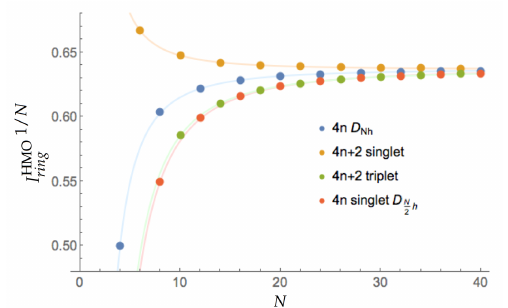
Figure 1. Values of I ring 1/ N for the annulenes series against the number of C atoms ( N ) for different singlets and triplets. The species have been divided according to the number of electrons (4 n and 4 n + 2) and the spin multiplicity (singlet and triplet).